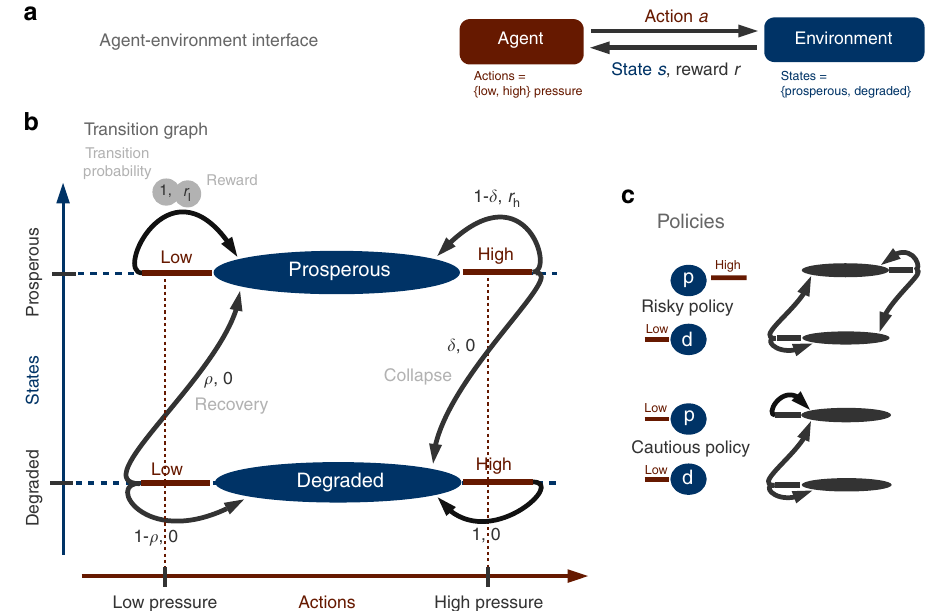
Fig. 1 Conceptual model of a human-environment tipping element. a Agent-environment interface: based on the state information and received reward, the agent chooses an action a from its actions set to gain rewards. b The transition graph gives state transition probabilities and corresponding rewards for all triples of state s , action a , next state s ′ , i.e., in state s the agent takes action a and moves to state s ′ . c Risky and cautious policies including the resulting Markov chains as a transition